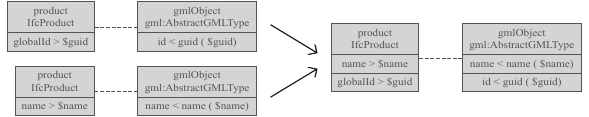
Figure 13. Rules for GML ID and GML name, combined into one rule.